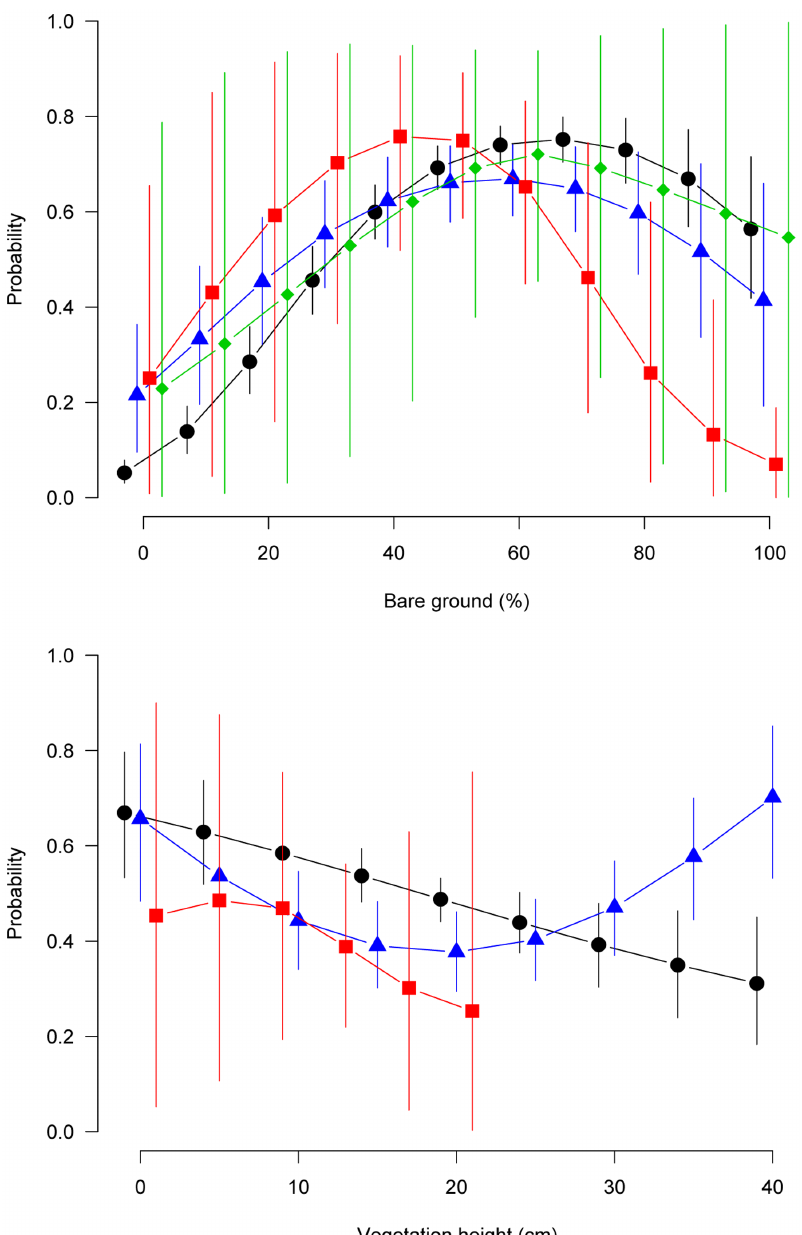
Figure 1. Marginal selection probability of foraging locations in relation to amount of bare ground and vegetation height for four farmland bird species. Predictions are revealed from the best models (see the supporting information) and refer to hoopoes (black dots), wrynecks (blue triangles), woodlarks (red squares) and common redstarts (green diamonds). Note that selection probabilities below 0.5 indicate avoidance, selection probabilities above 0.5 indicate preference. Points are posterior means, vertical lines show the limits of the 80% credible intervals.